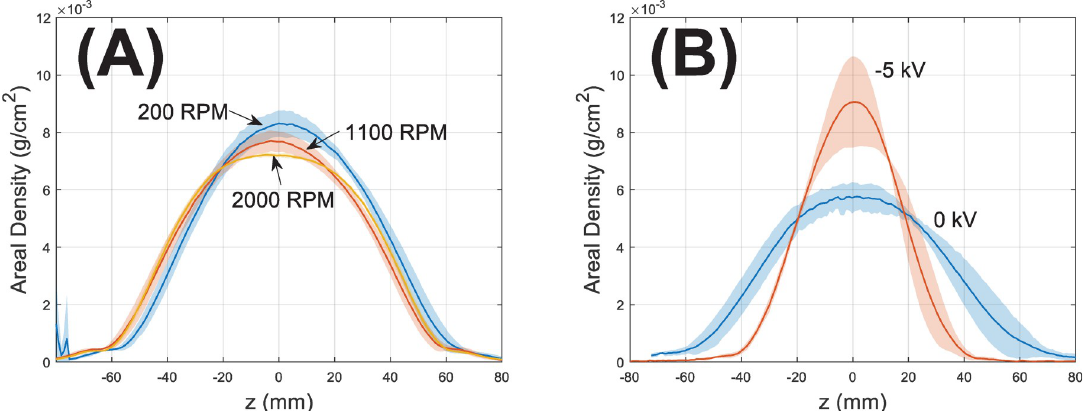
Fig 8. Effects of (A) RPM and (B) collector bias (data derived from our prior work [19]) on the mass distribution of depositions along axial (z) direction. Values are calculated from densified thickness and bulk PCL density of 1.145 g/cm3. The solid line represents the mean, and the shaded area represents the range of ± one standard deviations across different depositions. To emphasize symmetry, the axial coordinates are centered with the as-deposited peak as the origin (z = 0).